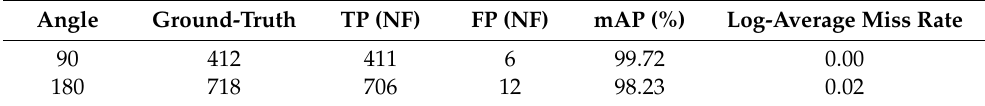
Table 15. The experimental results of different angle RM.